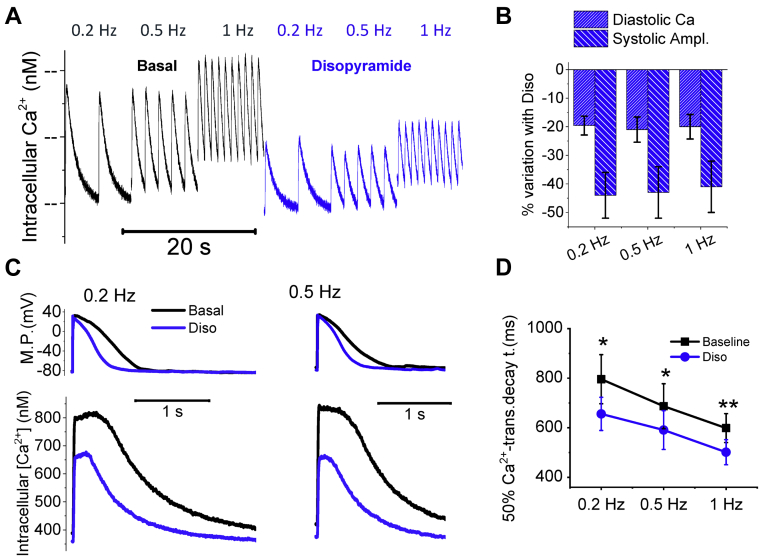
Effects of Disopyramide on Intracellular Ca2+(A) Representative intracellular Ca2+ traces recorded during regular stimulation at 0.2, 0.5, and 1 Hz, in the absence (left, black) and presence of disopyramide 5 μmol/l (Diso) (blue traces on the right). (B) Percentage of variation of diastolic [Ca2+]i, and Ca-transient amplitude (Systolic Ampl) with the application of disopyramide 5 μmol/l with respect to baseline in hypertrophic cardiomyopathy cardiomyocytes, during regular stimulation at 0.2, 0.5, and 1 Hz at steady state. (C) Representative superimposed action potentials (top) and simultaneously recorded Ca transients (bottom) at baseline (black traces) and in the presence of disopyramide (blue traces), elicited at 0.2 Hz (left) and 0.5 Hz (right). (D) Time from peak to 50% decay of Ca transients at baseline (black) and in the presence of disopyramide 5 μmol/l (blue), elicited at 0.2, 0.5, and 1 Hz. (B to D) Mean ± SEM from 26 cardiomyocytes from 7 patients with hypertrophic cardiomyopathy (ID# 5 to 9 and 11 to 13). *0.05 > p > 0.01; **0.01 > p > 0.001; linear-mixed models. MP = membrane potential.